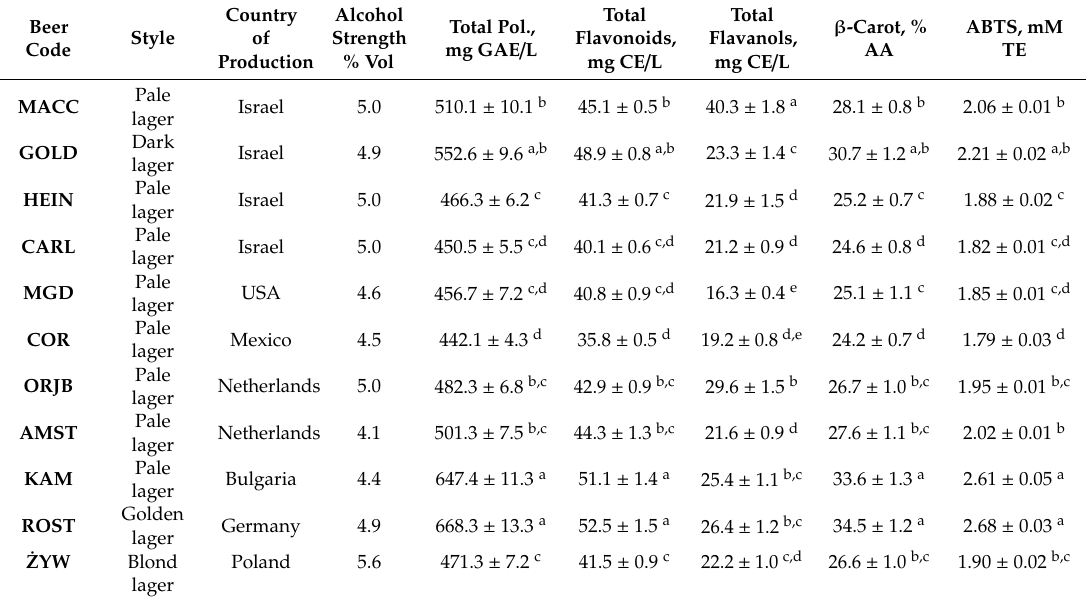
Table 1. Antioxidant properties of beer